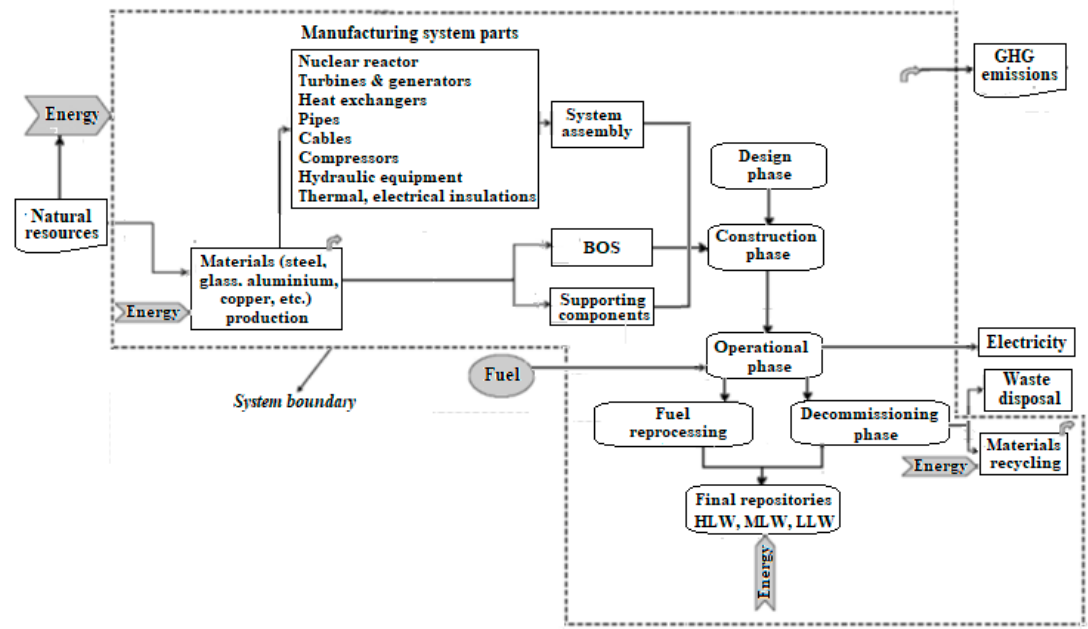
Figure 1. System boundary for the part of nuclear cycle under consideration.